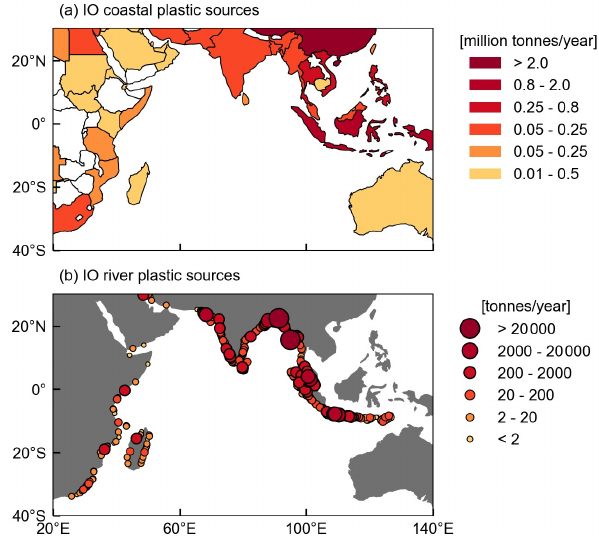
Figure 1. (a) Estimated coastal sources of plastic waste entering the Indian Ocean, based on data from Jambeck et al. (2015). Plastic waste input estimates for Sri Lanka have been reduced by a fac- tor of 10 in this map to correct for a mistake in the Jambeck et al. (2015) data. (b) Estimated river sources of plastic waste entering the Indian Ocean, based on data from Lebreton et al. (2017). The riverine inputs from Australia are negligible due to lack of major rivers. Please note that country boundaries in (a) are from outputs of scientific computer simulations and may not represent political and/or geographical